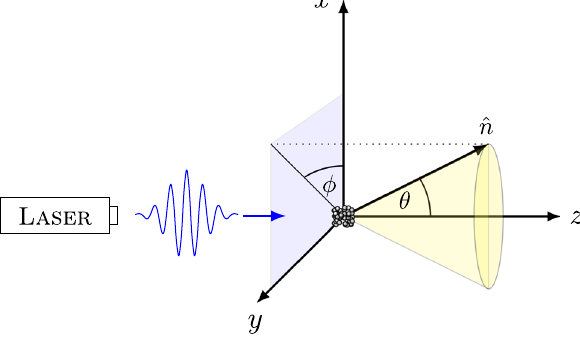
FIG. 1. Schematic diagram representing the numerical setup. The angles θ and ϕ are respectively measured with respect to þ z and þ x axis. The laser is incident from left on the cluster centered around origin and ˆ n points along the unit vector toward detection direction from the instantaneous position of the charged